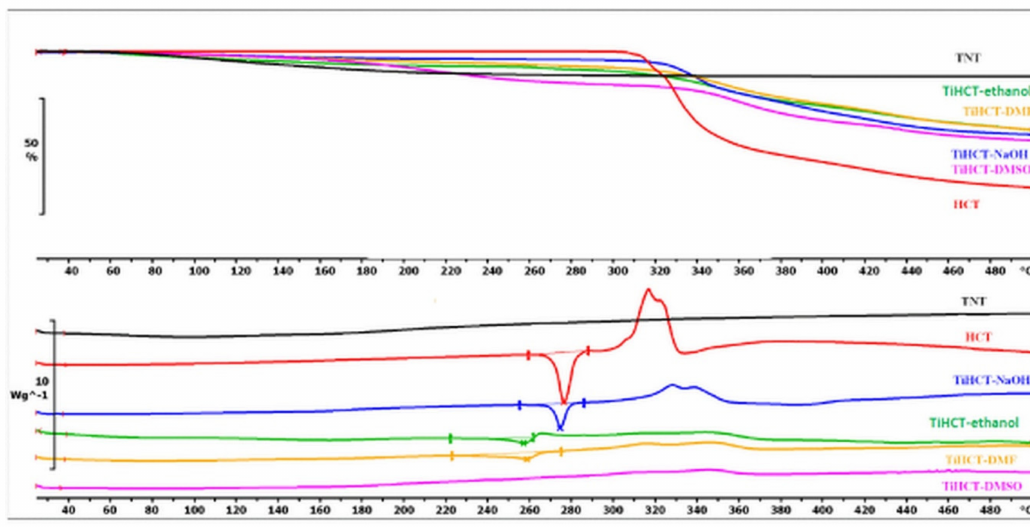
Figure 8. DSC and TG curves of TNT, HCT, TiHCT–ethanol, TiHCT–NaOH, TiHCT–DMF, and TiHCT–DMSO.